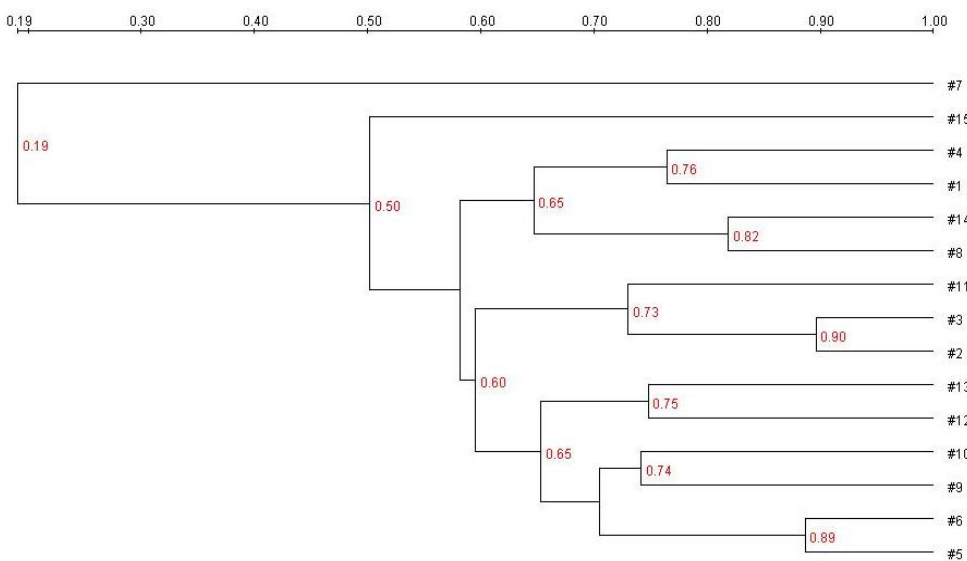
Figure 2. DGGE fingerprint for the total bacterial microbiota obtained from mouse distal colon. Lanes 1–3 (Group A) represent normal controls. Lanes 4–6 (Group B) represent infection models. Lanes 7–9 (Group C) represent infected mice treated with low-dose FTBE. Lanes 10–12 (Group D) represent infected mice treated with middle-dose FBTE, and lanes 13–15 (Group E) represent infected mice treated with high-dose FBTE. The arrows (i–viii) indicate bands that changed in intensity.